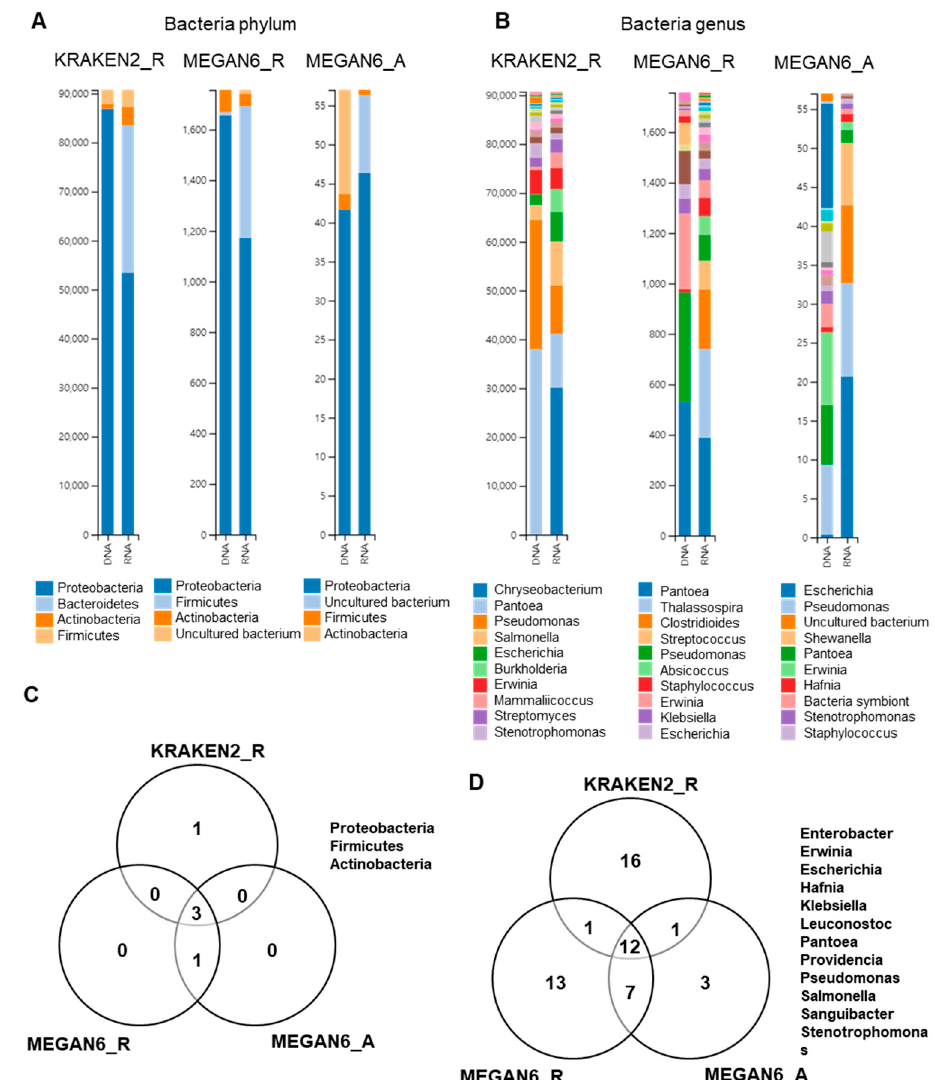
Figure 8. Comparison of identified bacteria at phylum and genus levels by three different analytical methods (i.e., KRAKEN2_R, MEGAN6_R, and MEGAN6_A). Proportion of identified bacterial phyla ( A ) and genera ( B ). Commonly identified phyla ( C ) and genera ( D ) among three different analytical methods.